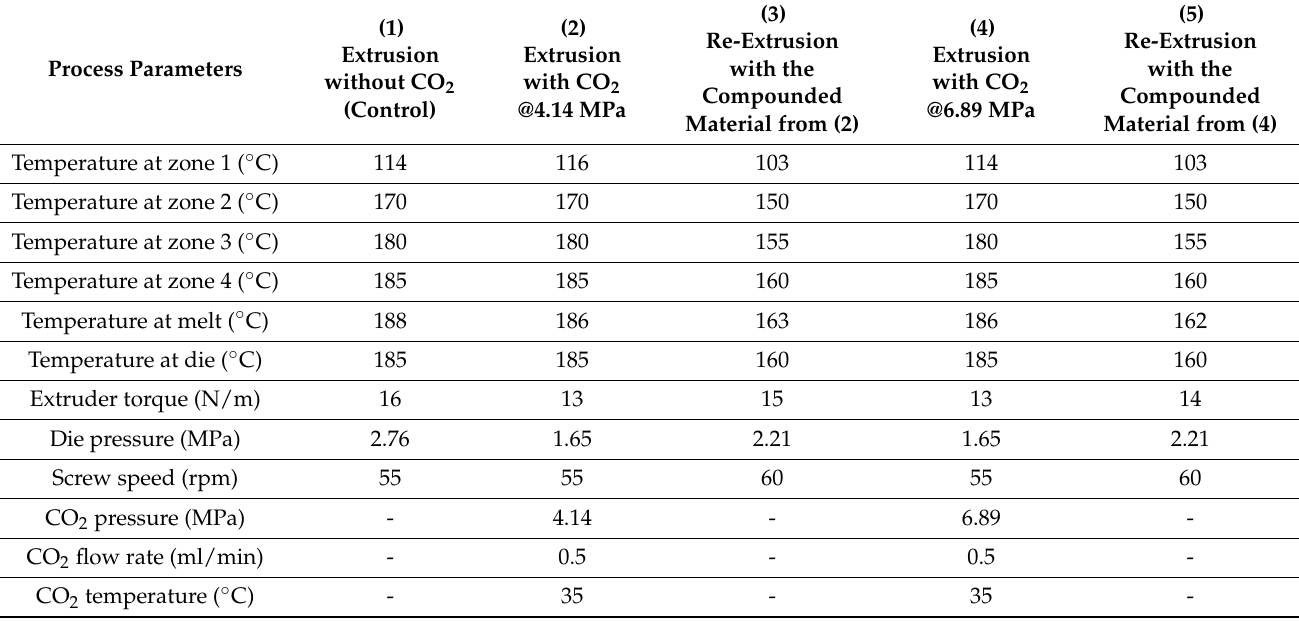
Table 2. Extrusion conditions and processing observations of Pellethane TPU with and without CO 2